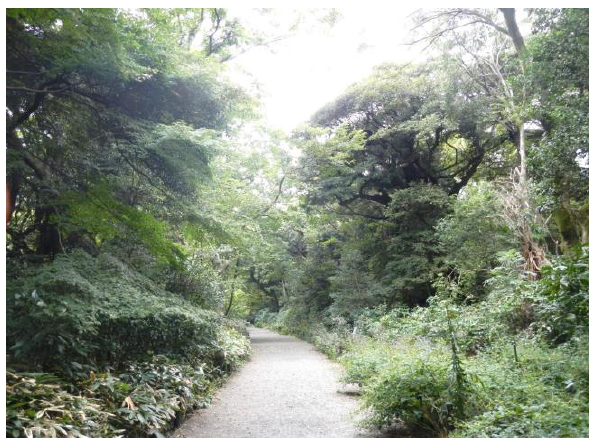
Figure 5. Figure placement and numbering